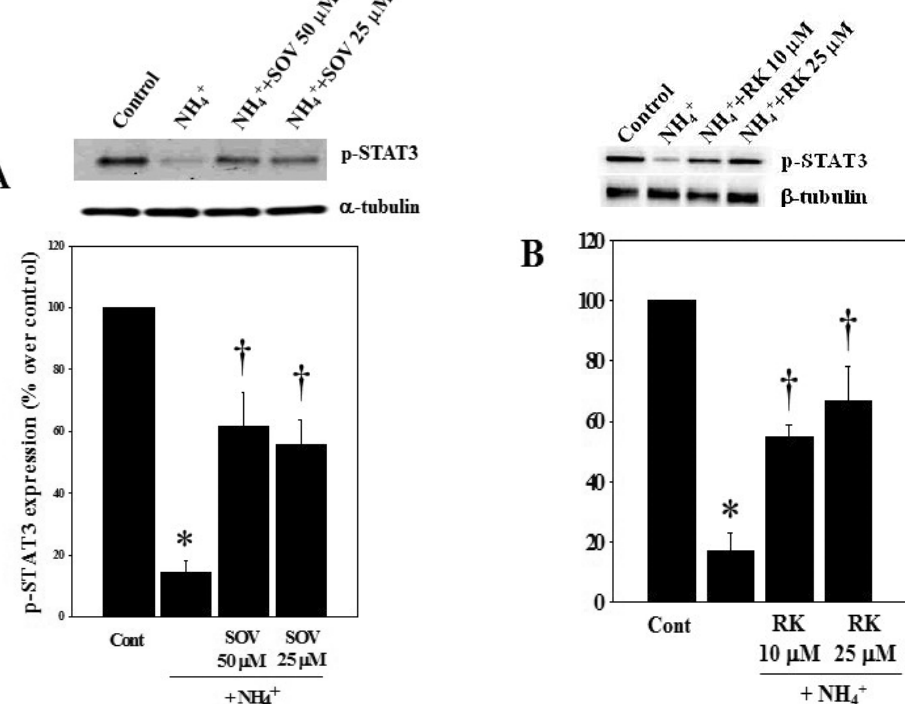
Figure 4. Effect of a protein phosphatase inhibition on the ammonia-induced (NH 4 Cl; 5 mM) STAT3Tyr705 phosphorylation (24 h) in cultured astrocytes. ( A ) Western blot analysis displayed a reversal of the ammonia-induced STAT3Tyr705 dephosphorylation after pretreatment (15 min) of cultures with 25 µ M and 50 µ M of sodium orthovanadate (SOV); ( B ) Western blot analysis